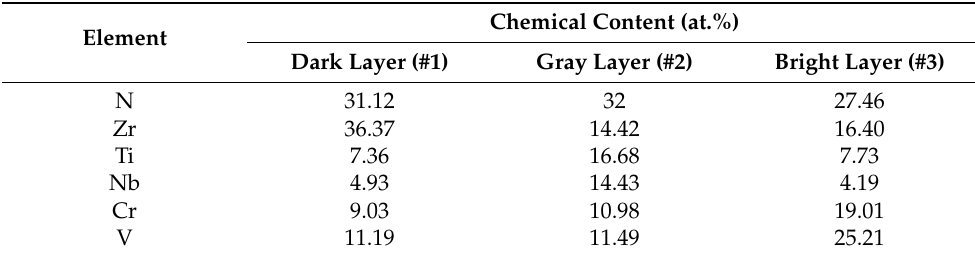
Chemical Content